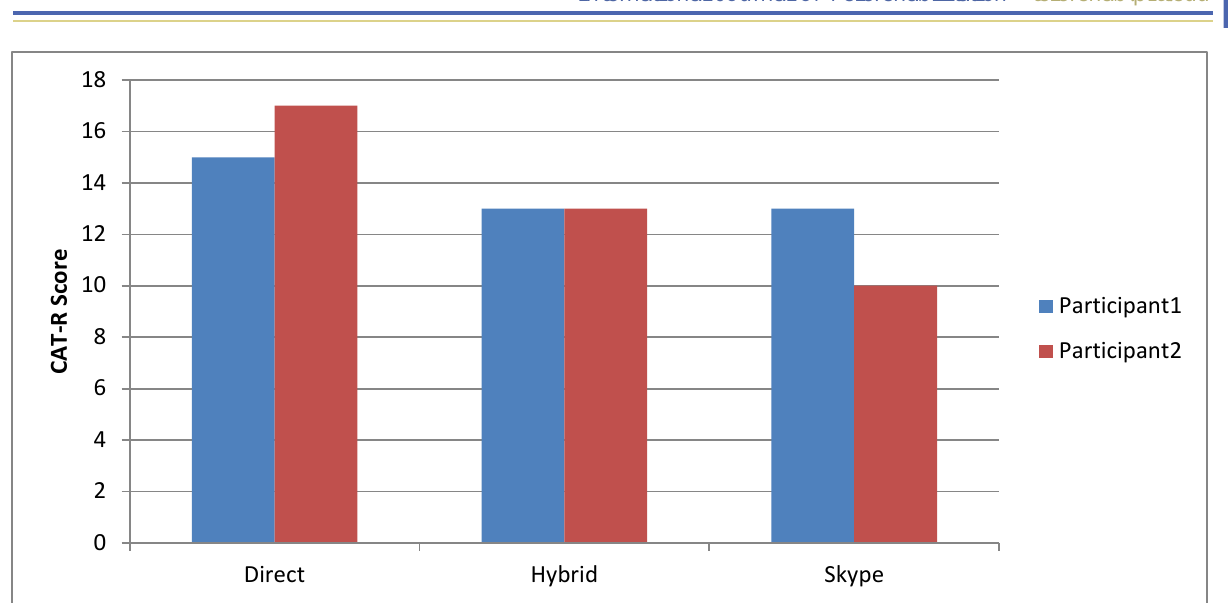
Figure 7. Communication Attitudes Test-Revised (CAT-R) scores for Participant 1 and Participant 2. [Mean for children who do not stutter: 8.17; Mean for children who stutter: 16.7].